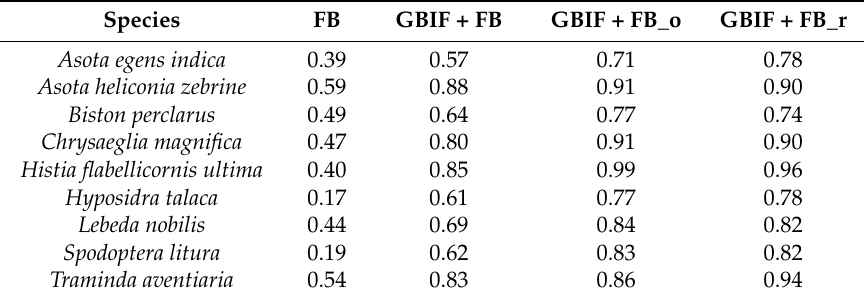
Table 3. Average correlation between species distribution models based on GBIF dataset and alternative combination dataset.